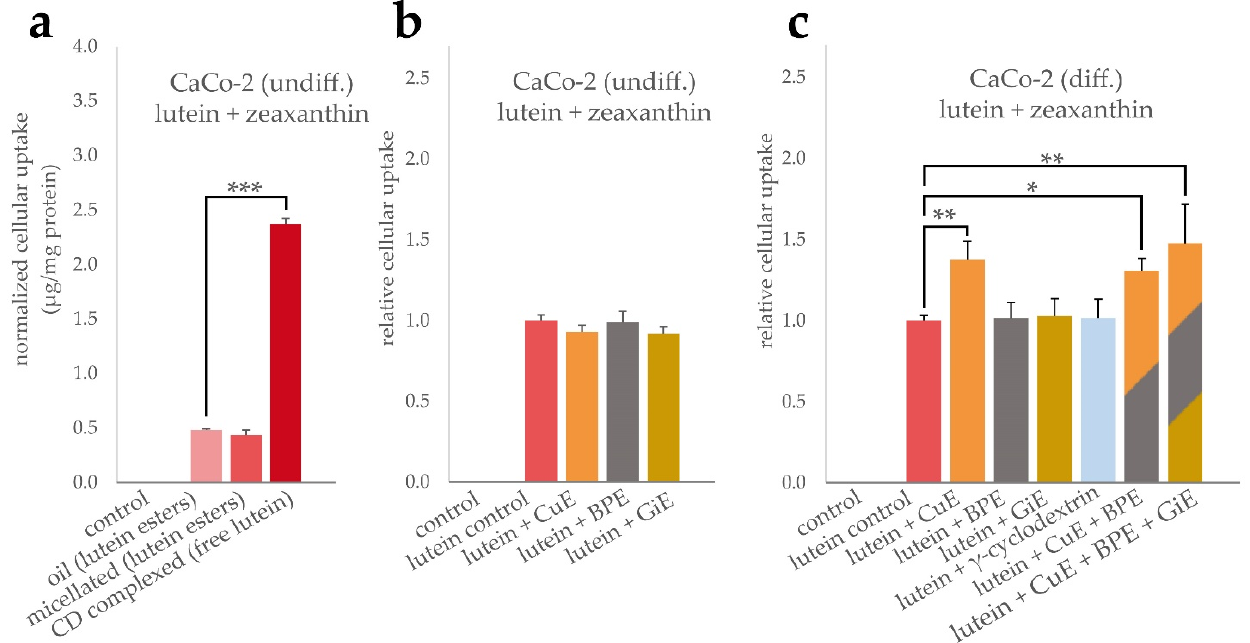
Figure 2. Uptake of lutein and zeaxanthin in CaCo-2 cells. To compare the uptake efficiency of the lutein formulations, cells were incubated for 4 h with lutein oil, micellated lutein or CD-complexed lutein at a final concentration of 14.7 µ g/mL lutein + zeaxanthin. Cellular uptake was quantified by HPLC after saponification and normalized to the total protein content ( a ). Influence of BPE, CuE and GiE at concentrations of 6 µ g/mL, 14.7 µ g/mL and 59 µ g/mL, respectively, on the cellular uptake of lutein were determined both in undifferentiated ( b ) and differentiated cells ( c ). Combinations of the extracts and addition of γ‐ cyclodextrin were studied in differentiated cells ( c ). In all cases, control experiments were performed without the addition of lutein and bioenhancer extracts. Error bars represent mean ± SEM ( n > 6). Statistically significant differences are denoted as* ( p ≤ 0.05), ** ( ≤ 0.01) and *** ( ≤ 0.001). Corresponding raw data are available in Supplementary Table S3–S5.